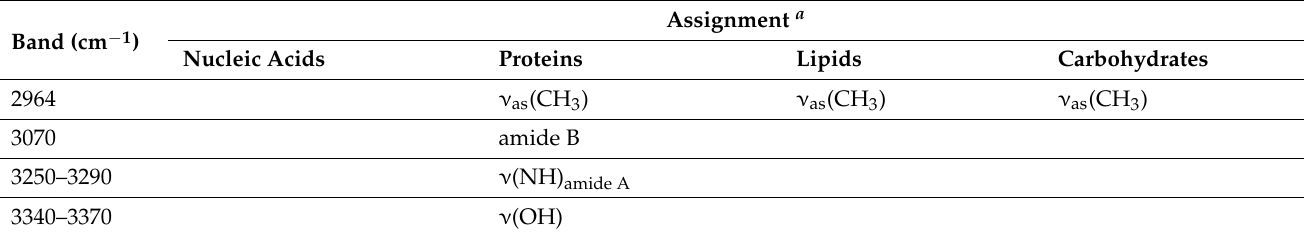
Table 1. Cont . Table 1. Raman and FTIR experimental data for the human breast cancer cell lines MDA-MB-231,